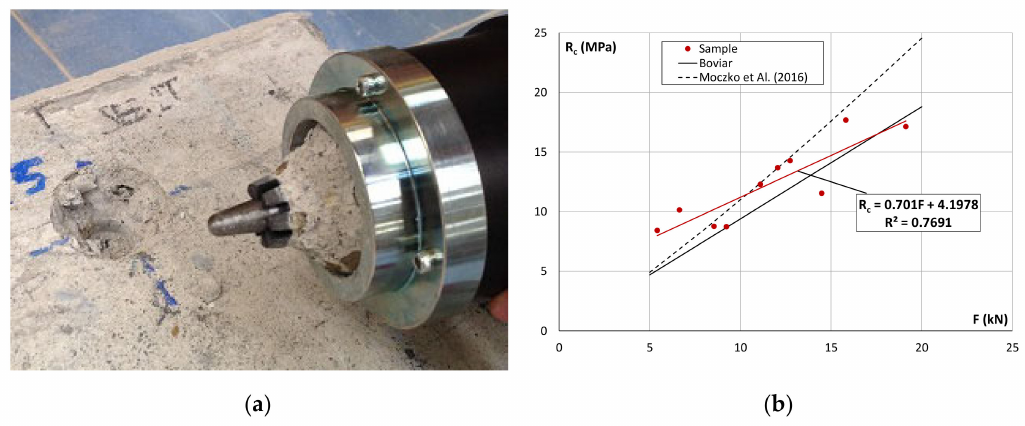
Figure 3. ( a ) Pull-out test; ( b ) correlation laws between F and R c.